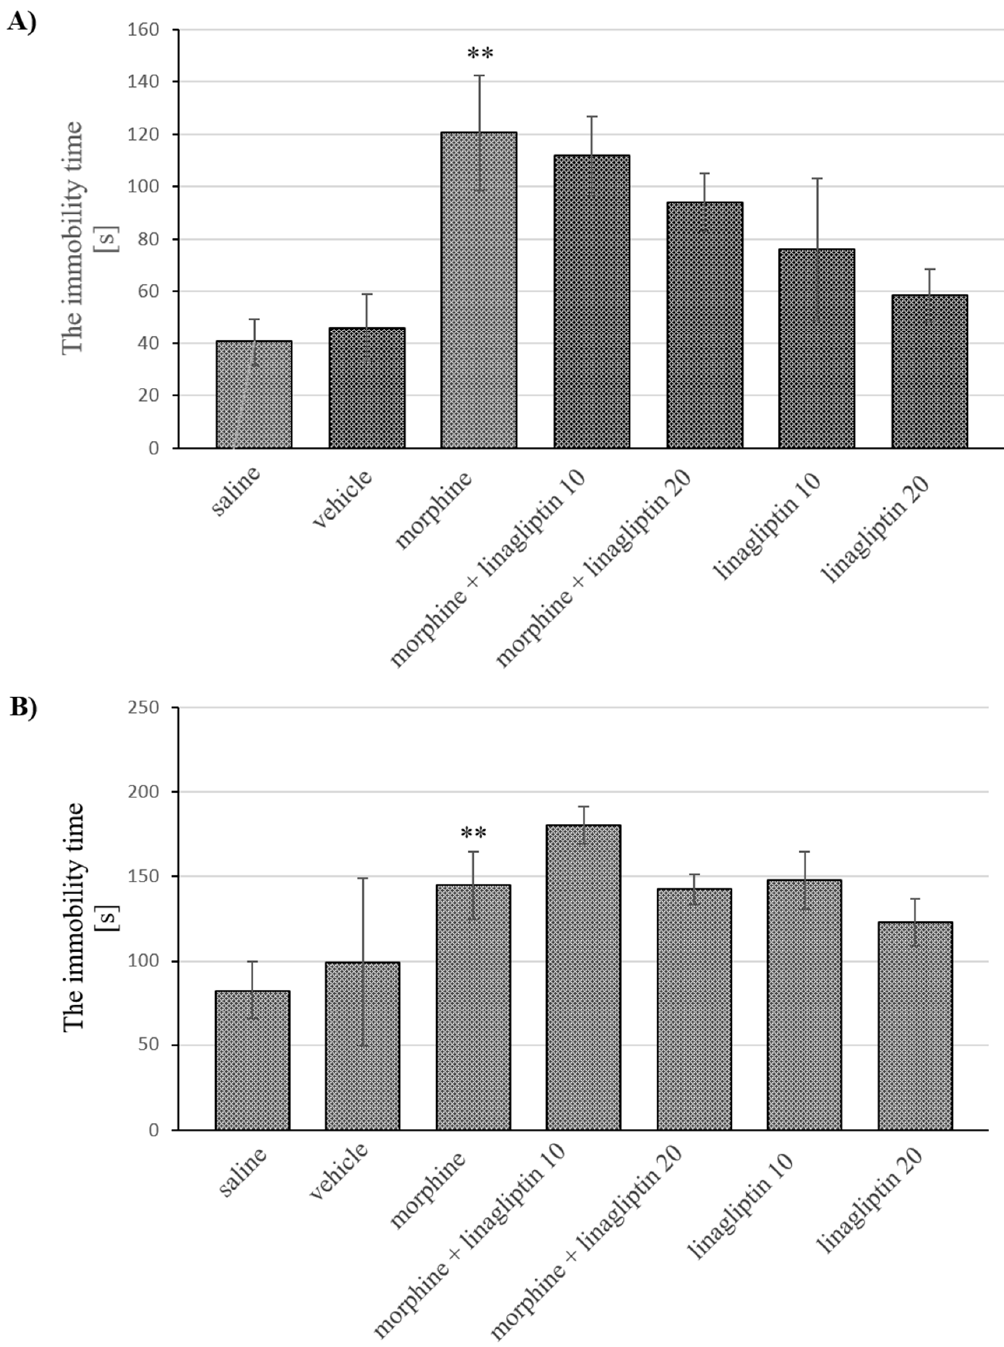
Figure 3. The influence of linagliptin (10 and 20 mg/kg, ip) administered simultaneously with morphine on depressive behavior observed in mice, in the forced swim test, during: ( A ) short-term (60 h) and ( B ) long-term (14 days) morphine withdrawal. Morphine was administered twice a day for eight consecutive days (10, 15, 20, 25, 30, 35, 40 and 50 mg/kg, ip). Linagliptin was injected once a day, 30 min prior to morphine injection, in the morning (altogether, 8 injections). The effect of linagliptin on depressive effects during morphine withdrawal was observed 60 h or 14 days after the last morphine injection (short-term or long-term withdrawal of morphine, respectively). The depressive effect in mice was assessed in terms of the immobility time in the forced swim test. The results are shown as the average time (s) of animal immobility ± SEM. ** p < 0.01 vs. saline/vehicle group (the Tukey’s test).